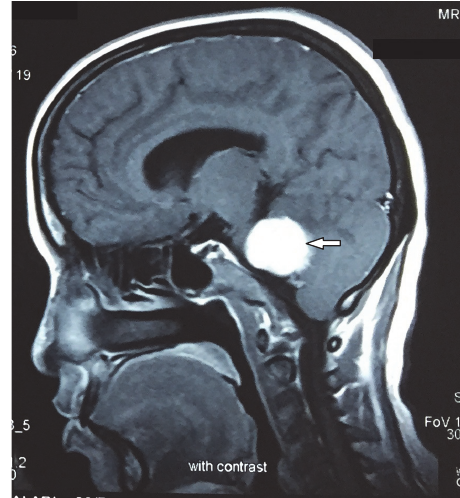
Figure 5: Postoperative image shows paralysis of face on right side.